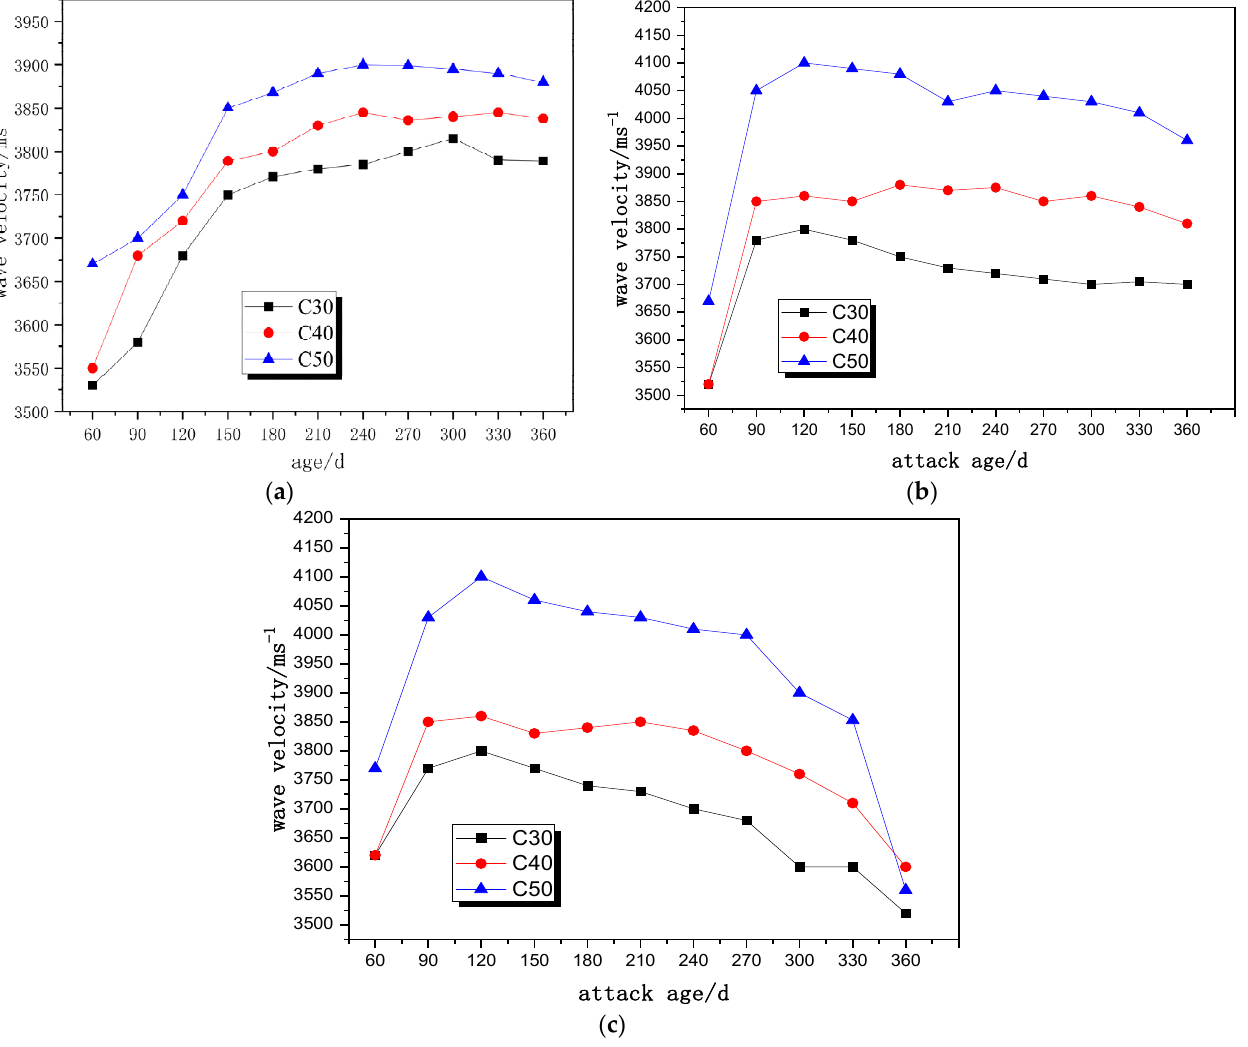
Figure 4. Wave velocity variation diagram of concrete at maximum stress level 0.7 and minimum stress level 0.2. ( a ) Sulfate concentration 0%; ( b ) sulfate concentration 5%; ( c ) sulfate concentration 10%.